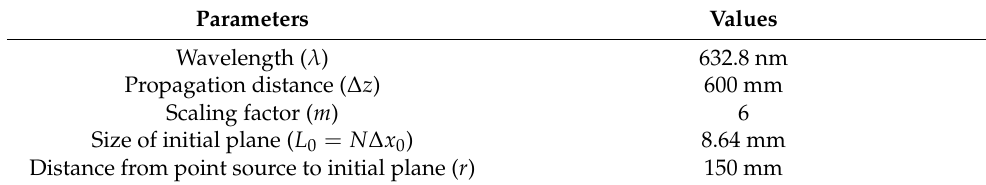
Table 2. The Simulation Parameters of Verification 2 of the Sampling Conditions.